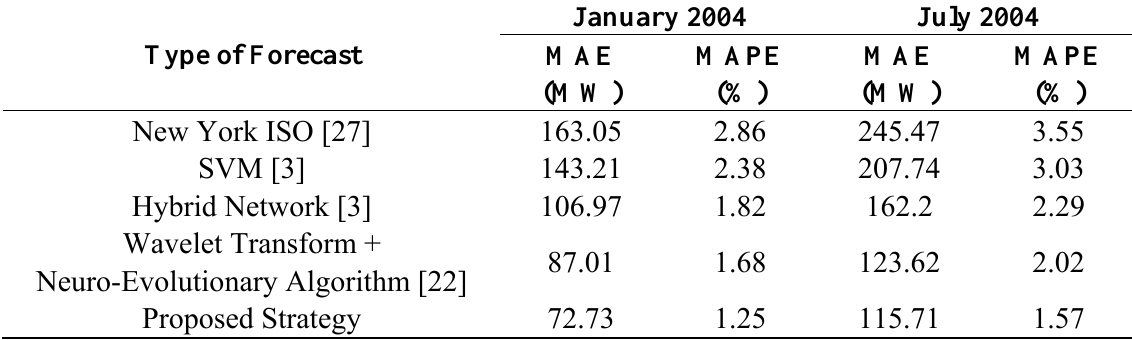
Table 5. Day-ahead STLF results of New York city for the two test months of January 2004 and July 2004.